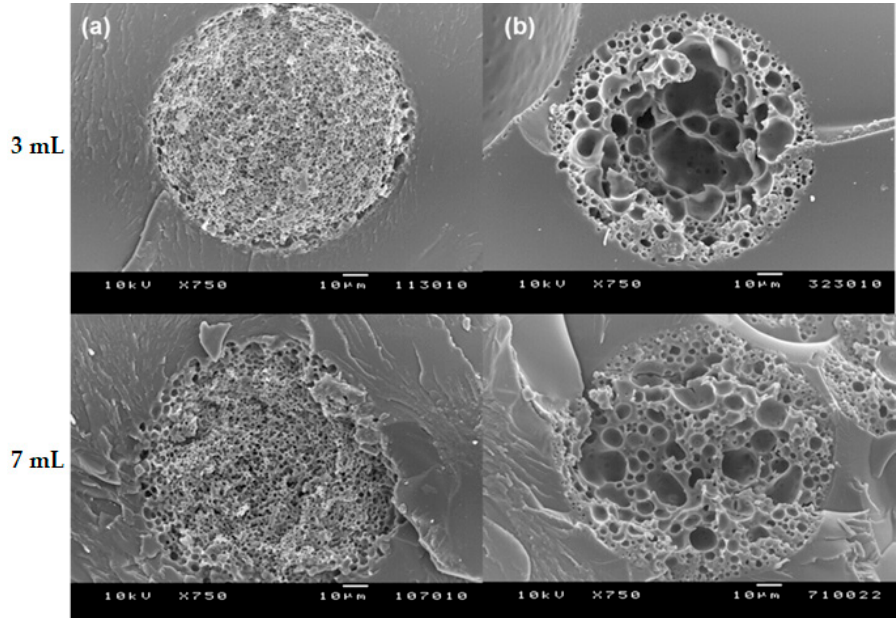
Figure 11. SEM images of the internal morphology of various PLGA microspheres ( a ) before and ( b ) after self-healing (bar size = 10 µm). Wet microspheres prepared using 3 mL and 7 mL of the ammonia solution were first incubated in 0.2% Tween 80 solution at RT for 2 h and were followed by self-healing.